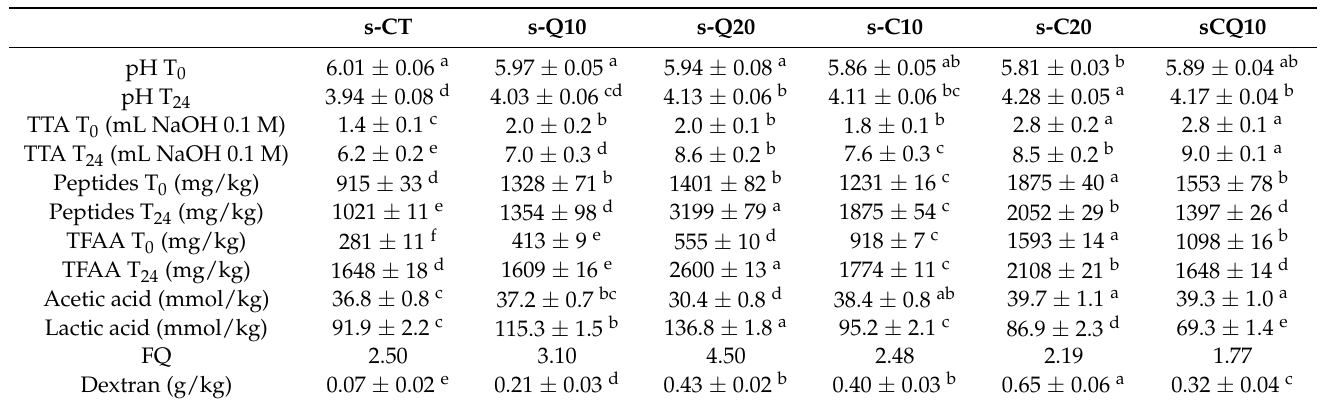
Table 4. Chemical evaluation of